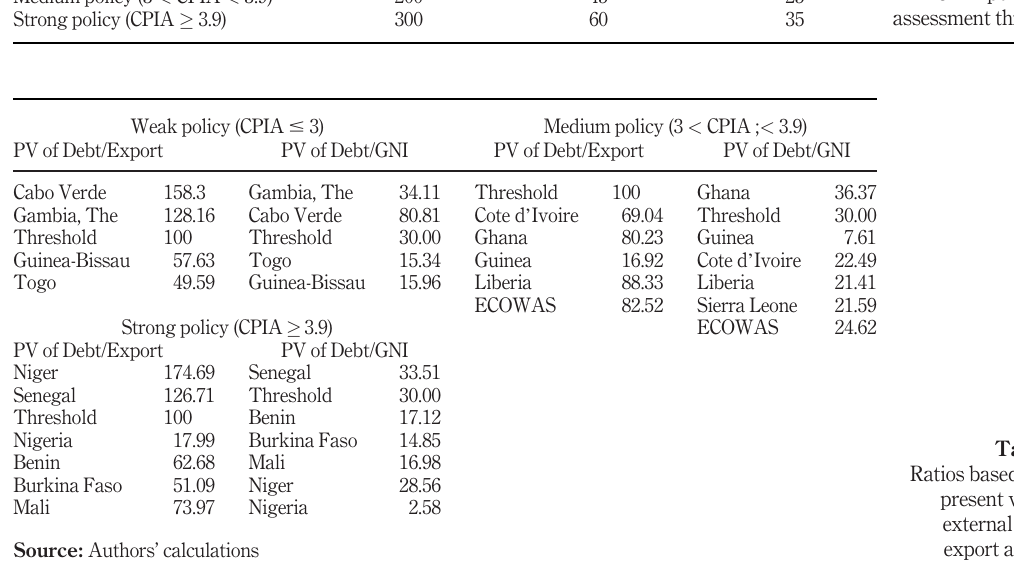
Table 7. CPIA policy and assessment